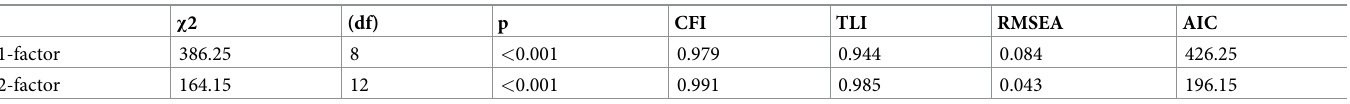
Table 3. Model fit indices of CFA.